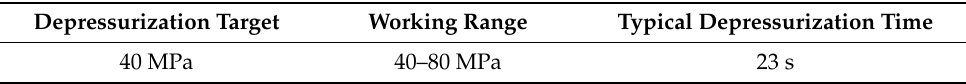
Table A4. Pressure